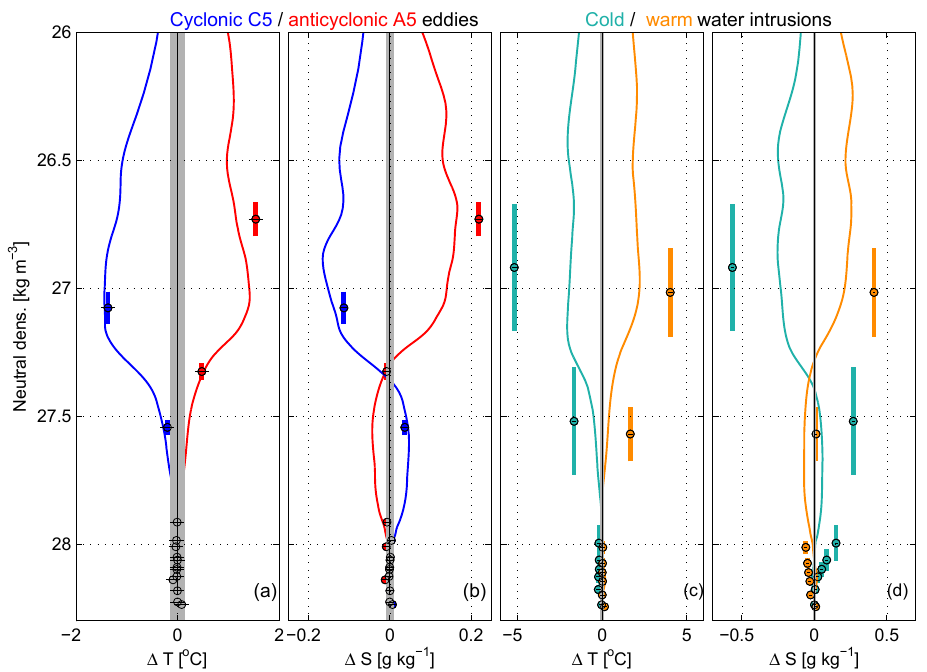
Figure 12. Vertical profiles of the conservative temperature (a, c) and absolute salinity (b, d) anomalies at M4 due to the presence of the anticyclonic and cyclonic eddies (a, b) and the two intrusions associated with the dipole (c, d) . The colored dots represent the anomalies from the SBE37 MicroCATs with their estimated accuracy (horizontal black line) and their range of neutral density variability (colored boxes). The solid colored lines represent the anomalies from the reconstructed GEM fields. The gray shaded areas around the horizontal zero axis show the range of value below the estimated measurement’s